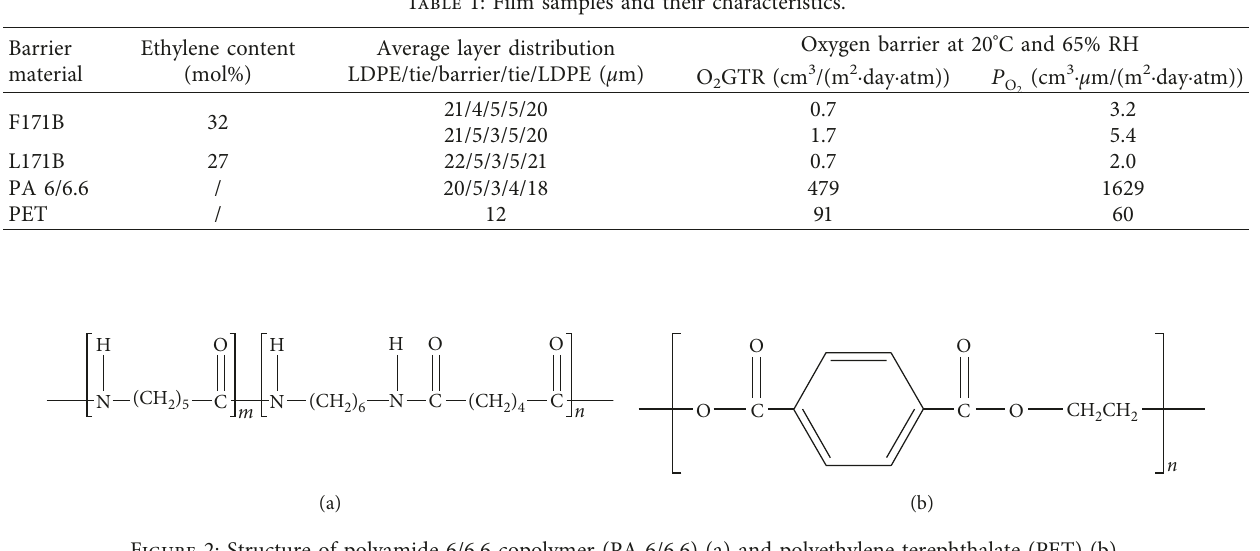
Figure 2: Structure of polyamide 6/6.6 copolymer (PA 6/6.6) (a) and polyethylene terephthalate (PET) (b).